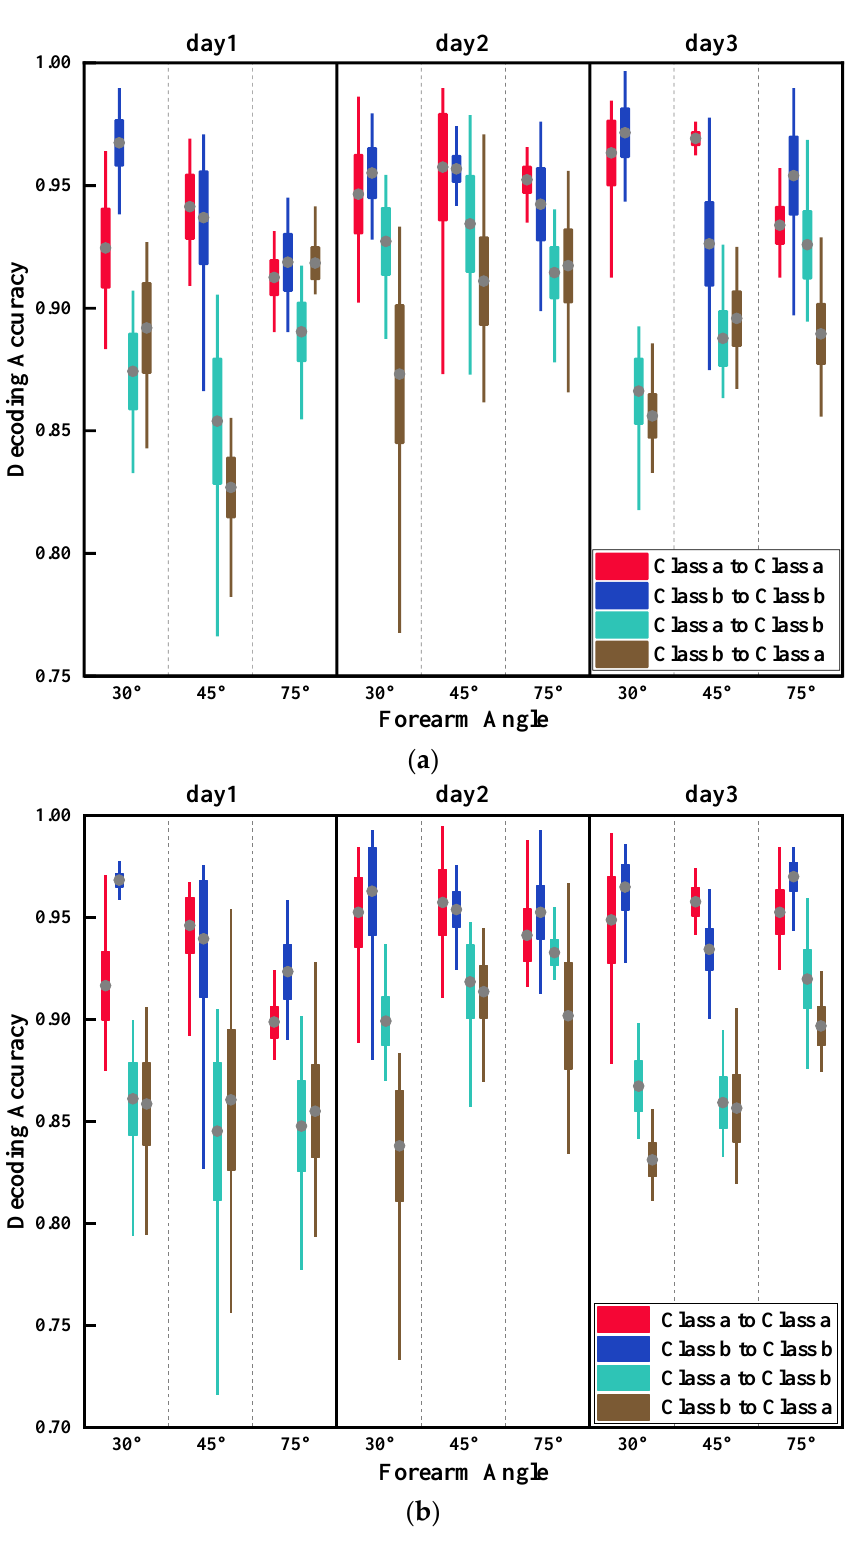
Figure 9. Influence of muscle fatigue on the accuracy of gesture decoding. Class 𝑎 to Class 𝑎 means to use Class 𝑎 datasets as training and testing datasets, and the same goes for Class 𝑏 to Class 𝑏 , while Class 𝑎 to Class 𝑏 means to use Class 𝑎 datasets as training datasets, Class 𝑏 as testing datasets, and the same goes for Class 𝑏 to Class 𝑎 . ( a ) Influence of muscle fatigue using LDA; ( b ) influence of muscle fatigue using PNN.